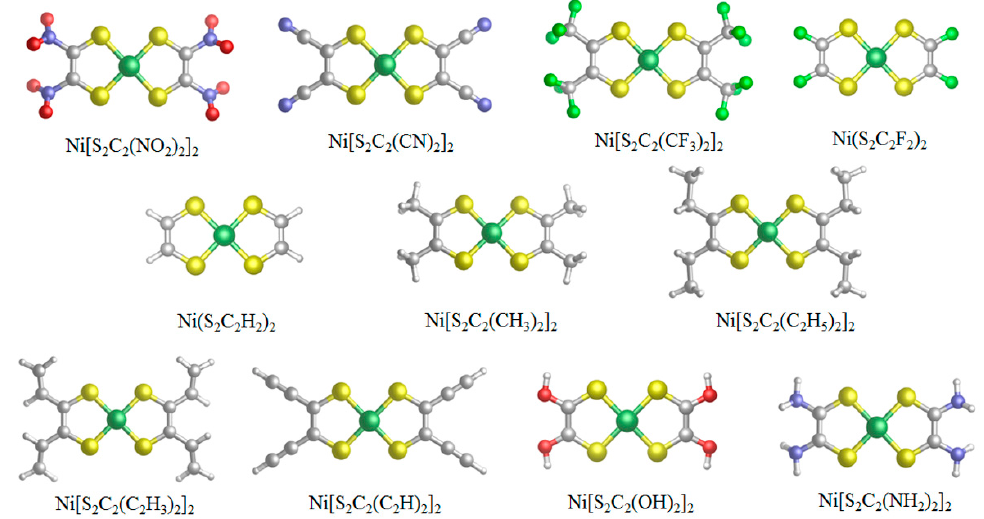
Figure 1. Geometries of Ni(S 2 C 2 R 2 ) 2 (R = –NO 2 , –CN, –CF 3 , –F, –H, –CH 3 , –C 2 H 5 , –CH=CH 2 , –C ≡ CH, –OH, –NH 2 ) optimized by Gaussian 09 software. Ni atom is in dark green; O atom is in red; N atom is in purple; S atom is in yellow; C atom is in gray; H atom is in white; F atom is in light green.